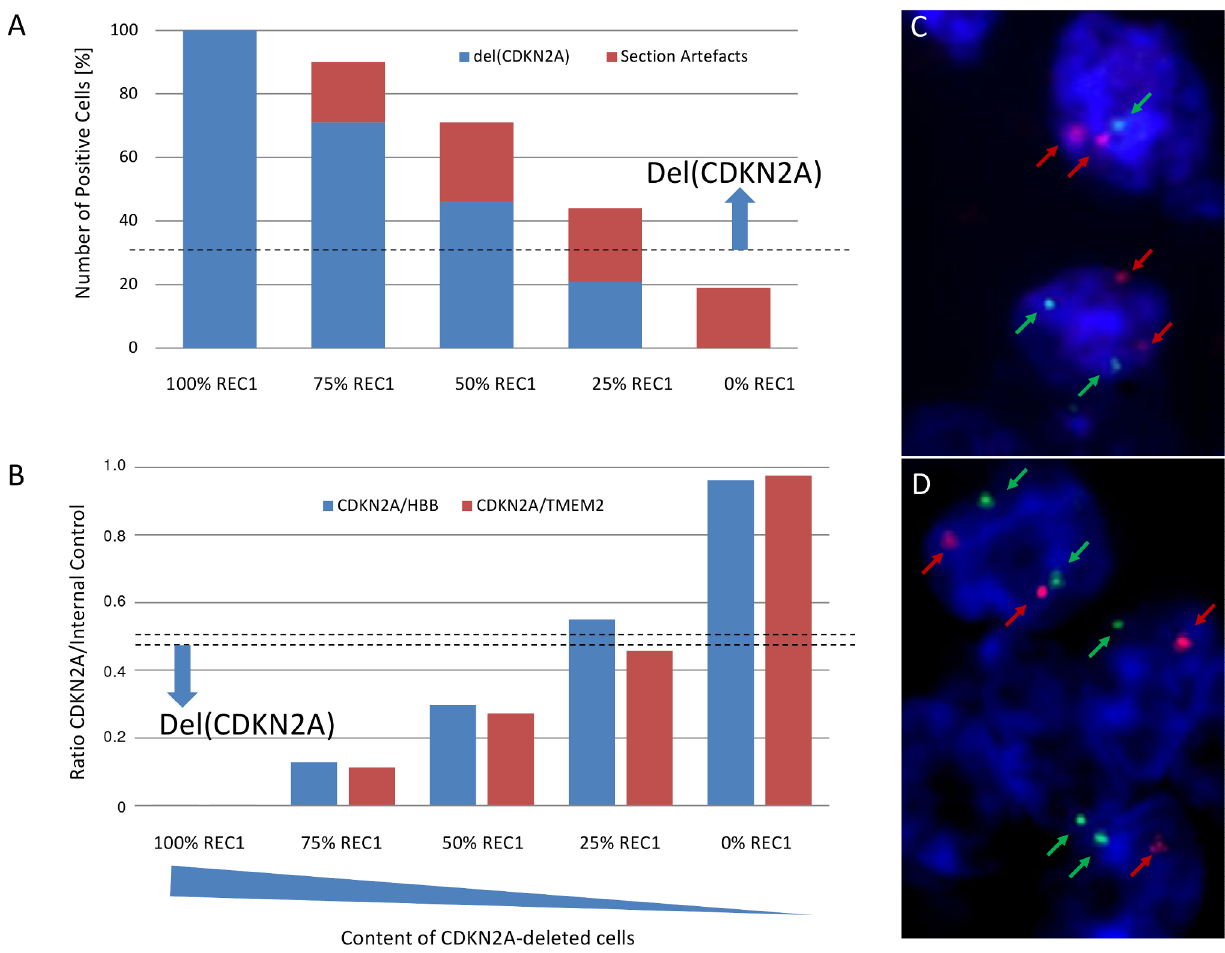
Figure 1. Experimental set up for the accurate testing of numerical genetic alterations in FFPE tumor tissue performing FISH (A) or qPCR (B). Using JVM2 and REC1 MCL cell lines, cell dilutions containing different amounts of CDKN2A -deleted cells were established (ranging from 0% to 100% CDKN2A -deleted cells). Representative FISH results (C–D), indicating the occurrence of section artefacts in cell suspensions containing only non-deleted CDKN2A (100% JVM2), by obtaining aberrant signal constellations not matching the expected signal distribution of two red and two green copies ( CDKN2A : marked in red; 9cen: marked in green, magnification: 100 6 ). The cut-off level obtained from investigation of reactive lymph node specimens is depicted as dashed line for the FISH (A) and the qPCR (B)